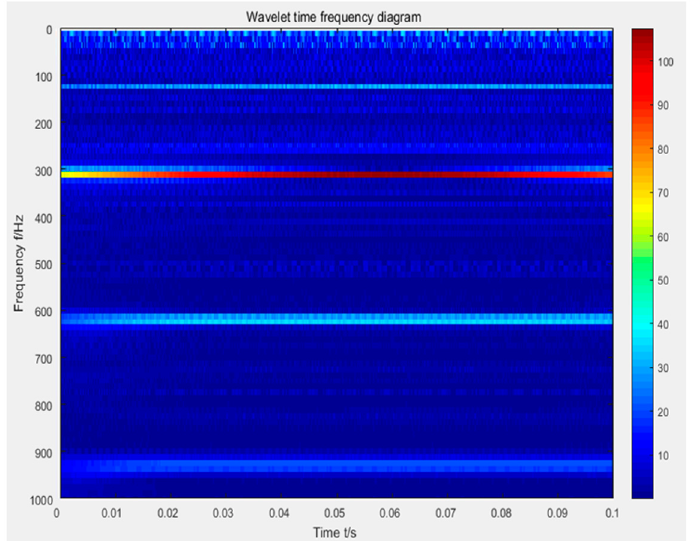
Figure 24. A wavelet spectrum analysis of a modified guide vane.